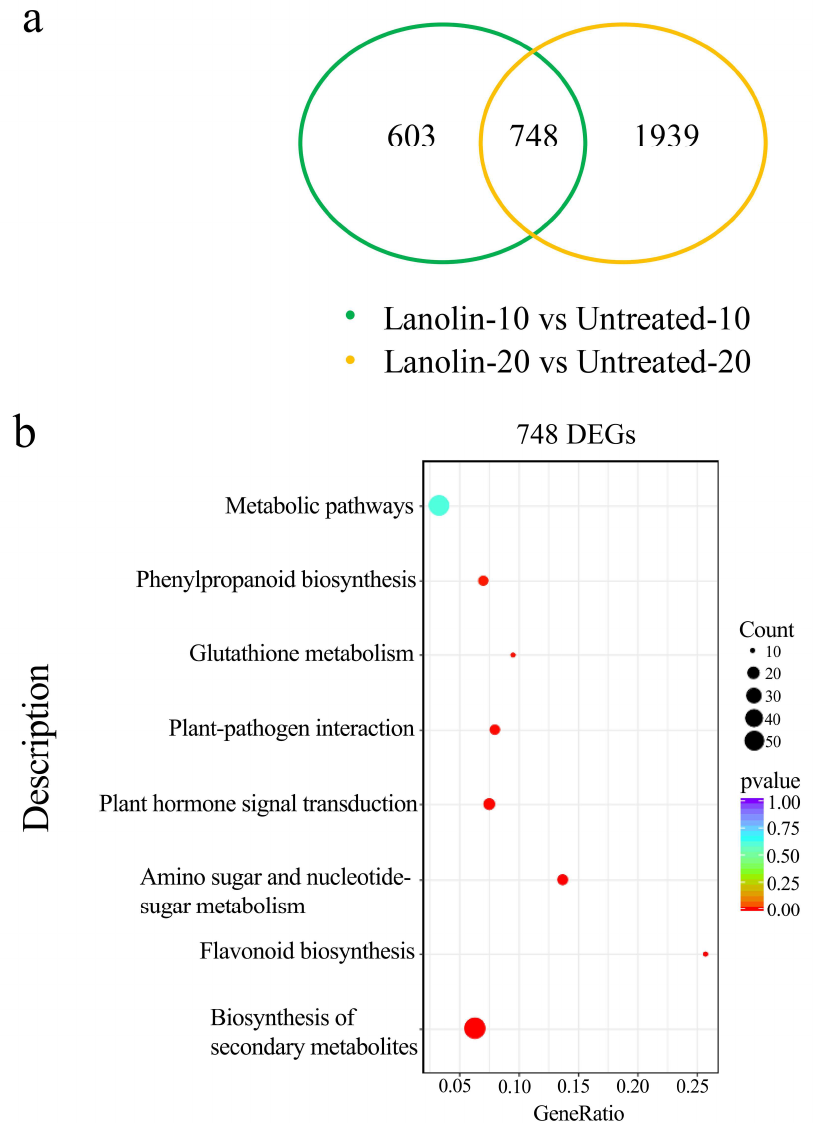
Figure 2. RNA-Seq analysis of untreated control and lanolin-treated ‘Zaosu’ pear fruit peels. ( a ) Venn diagram of the numbers of differential expression genes (DEGs) between untreated and lanolin-treated fruit peels at 10 and 20 days after treatment. ( b ) The Kyoto Encyclopedia of Genes and Genomes (KEGG) enrichment analysis of 748